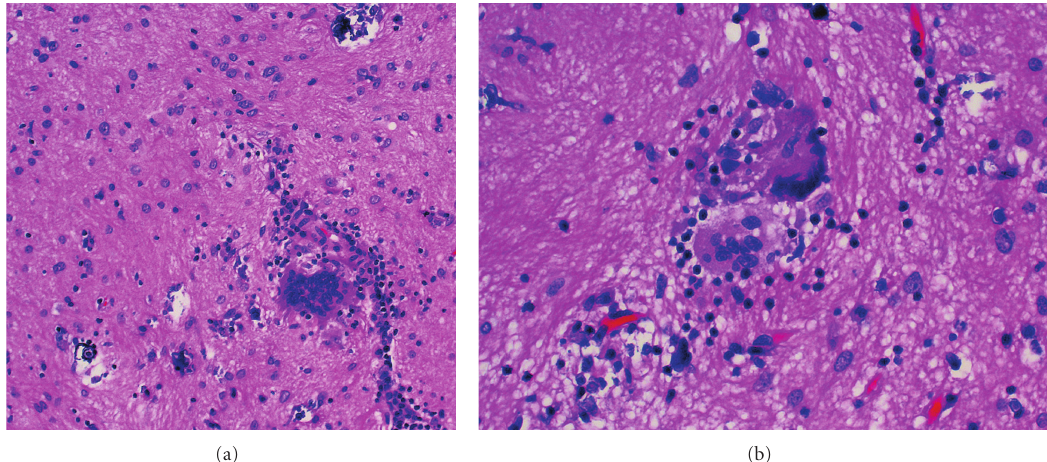
Figure 2: Histopathologic sections reveal chronic inflammation, astrogliosis, and scattered mineralizations [(a) H&E × 200]. Frequent multinucleated giant cells were present [(b): H&E × 400].